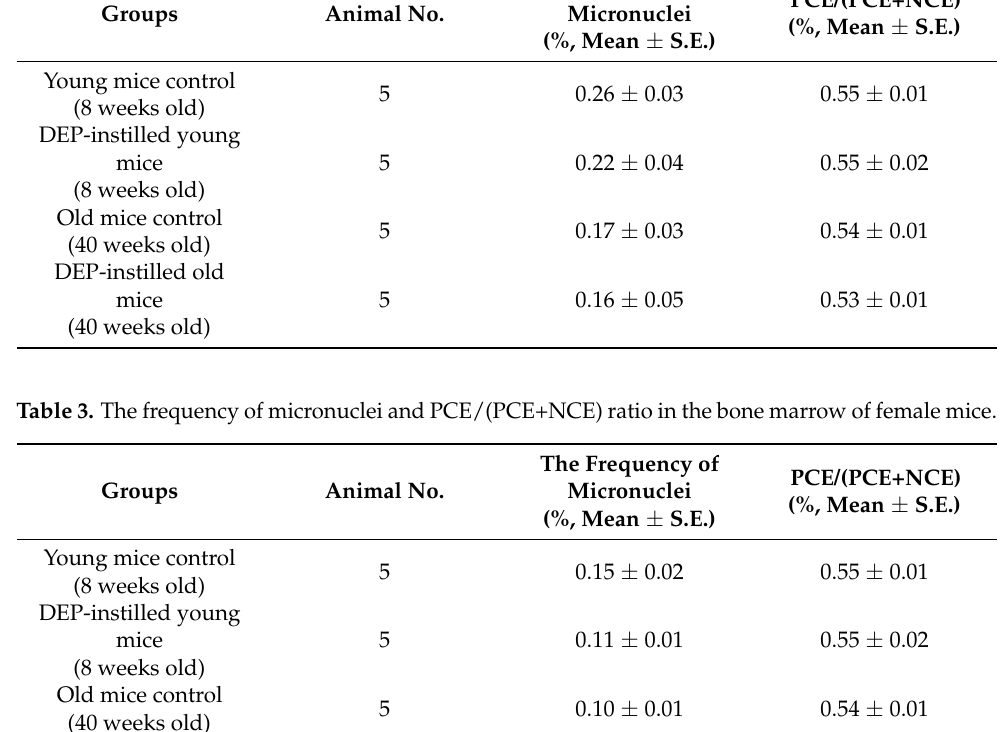
Table 2. The frequency of micronuclei and PCE/(PCE+NCE) ratio in the bone marrow of male mice. Groups Animal No.